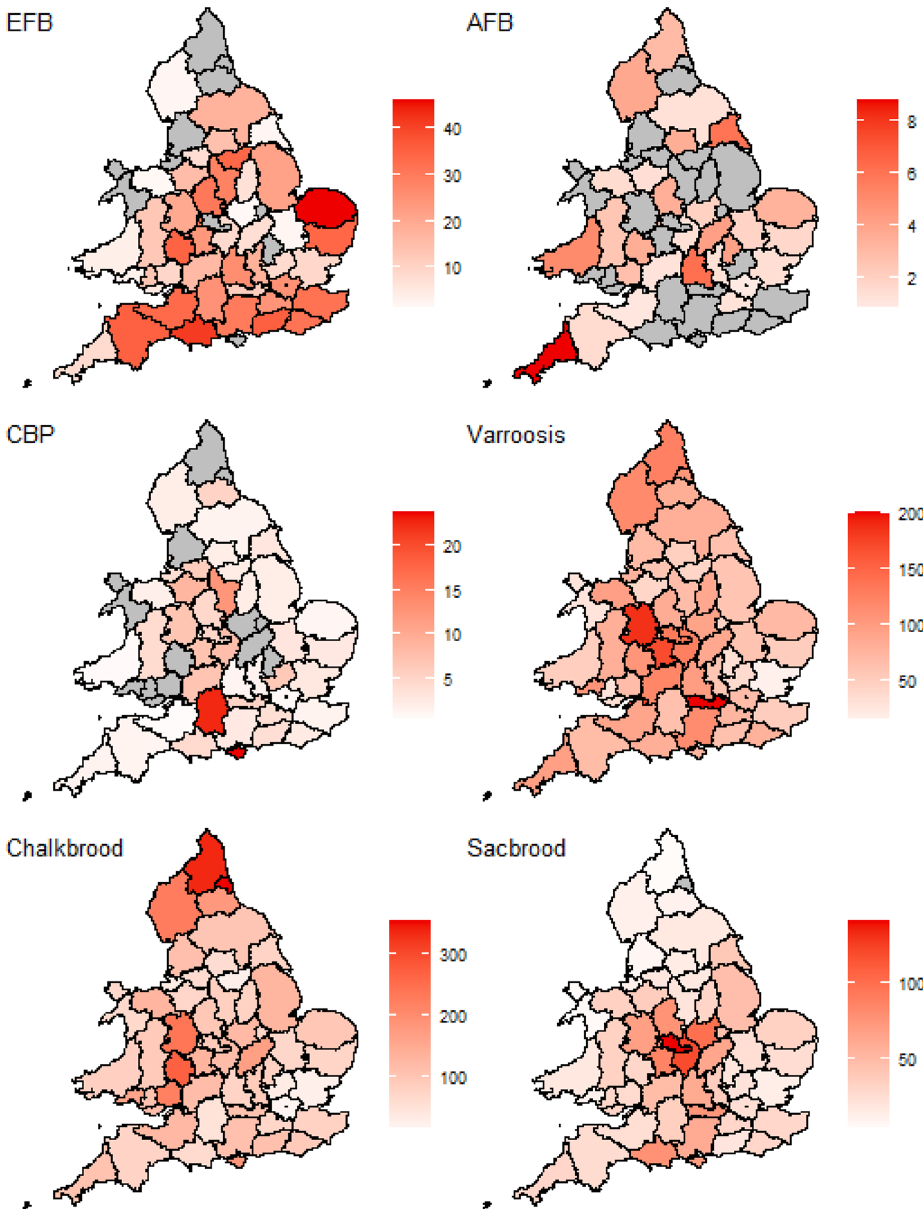
Figure 2. Total number of cases of different honey bee diseases in England and Wales between 2006 and 2016. Each county was normalized to cases per 1000 colonies visited to avoid inspection bias. To maintain confidentiality, data are greyed out when fewer than five apiaries were visited in a single county/year. The county boundaries for England and Wales were sourced from the Database of Global Administrative Areas (http:// GADM.